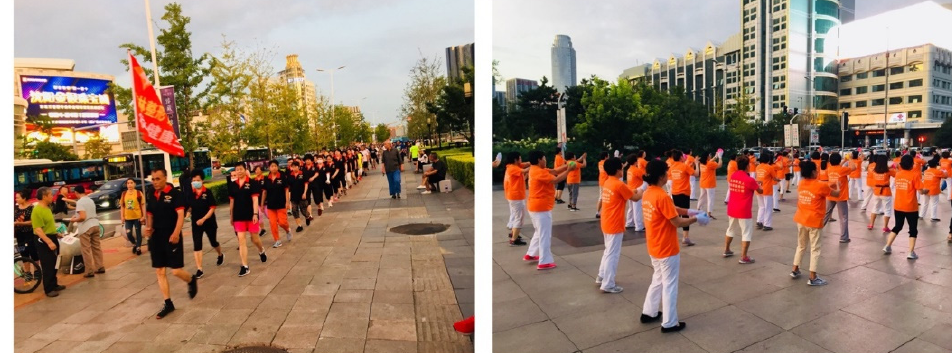
Figure 3. Image illustrating people who walk or dance with clothes sponsored by companies.